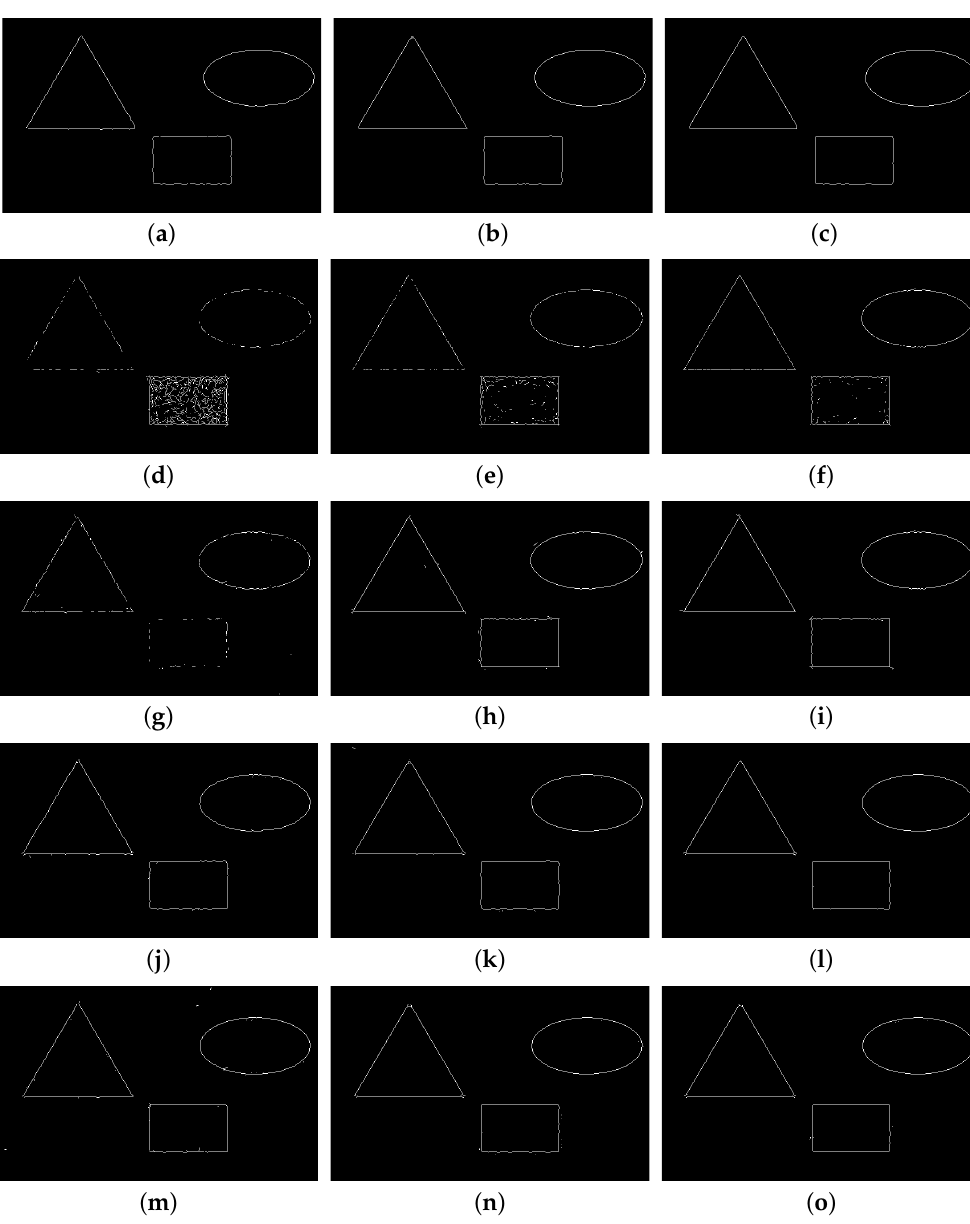
Figure 13. Edge binary maps on the simulated SAR images (Step); from left to right is result of the one-look, three-look, and six-look simulated images. ( a – c ) SAR-PC; ( d – f ) PC; ( g – i ) Log-PC; ( j – l ) Ratio-Based Edge Detector (RBED); ( m – o ) detector using Gaussian-Gamma-Shaped bi-windows